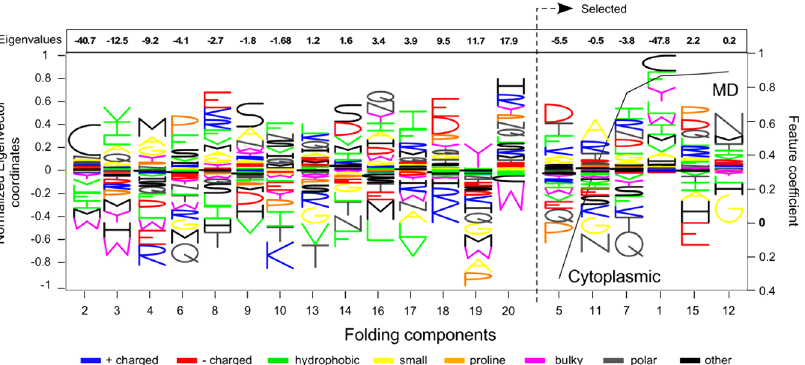
Figure 3. The selected folding features. Decomposition of the energy predictor matrix P to its eigenvectors 37 . Each element P of the P matrix, tells how the energy of the residue of type i affects the occurrences of the i j , residues of type j in the sequence 37 . We name the eigenvectors as folding components (FCs) because they represent a balance between stabilizing and destabilizing aminoacyl residues interactions. We represent each FC as a stack of letters (amino acids one letter code) where the size of each letter is proportional to the corresponding coordinate of the respective eigenvector. The black line denotes the weights of the linear classifier trained using the total energy per folding component (see Methods), termed as the “disorder classifier”. The FCs are rearranged per the weights of the classifier and are numbered in decreasing order of the respective eigenvalues, indicated at the top. Positively weighted FCs are selected for the mature domain sequences. For example, mature domains are composed mostly of Gln, Thr and Lys as the seventh FC